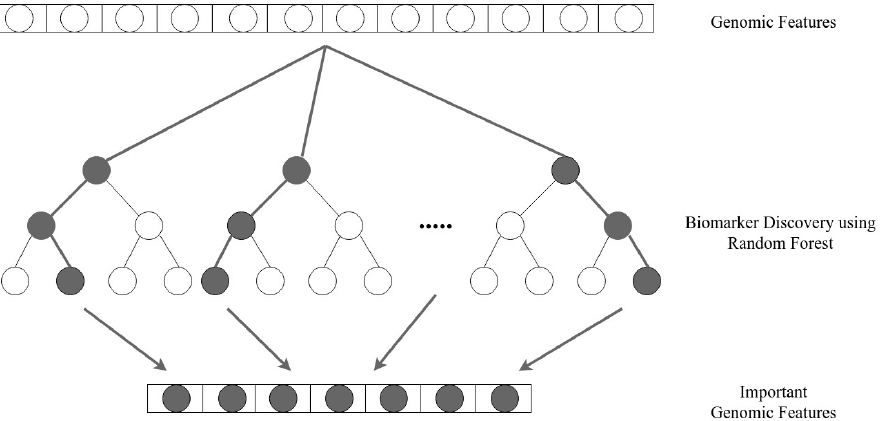
Figure 1. Biomarker discovery using random forest.